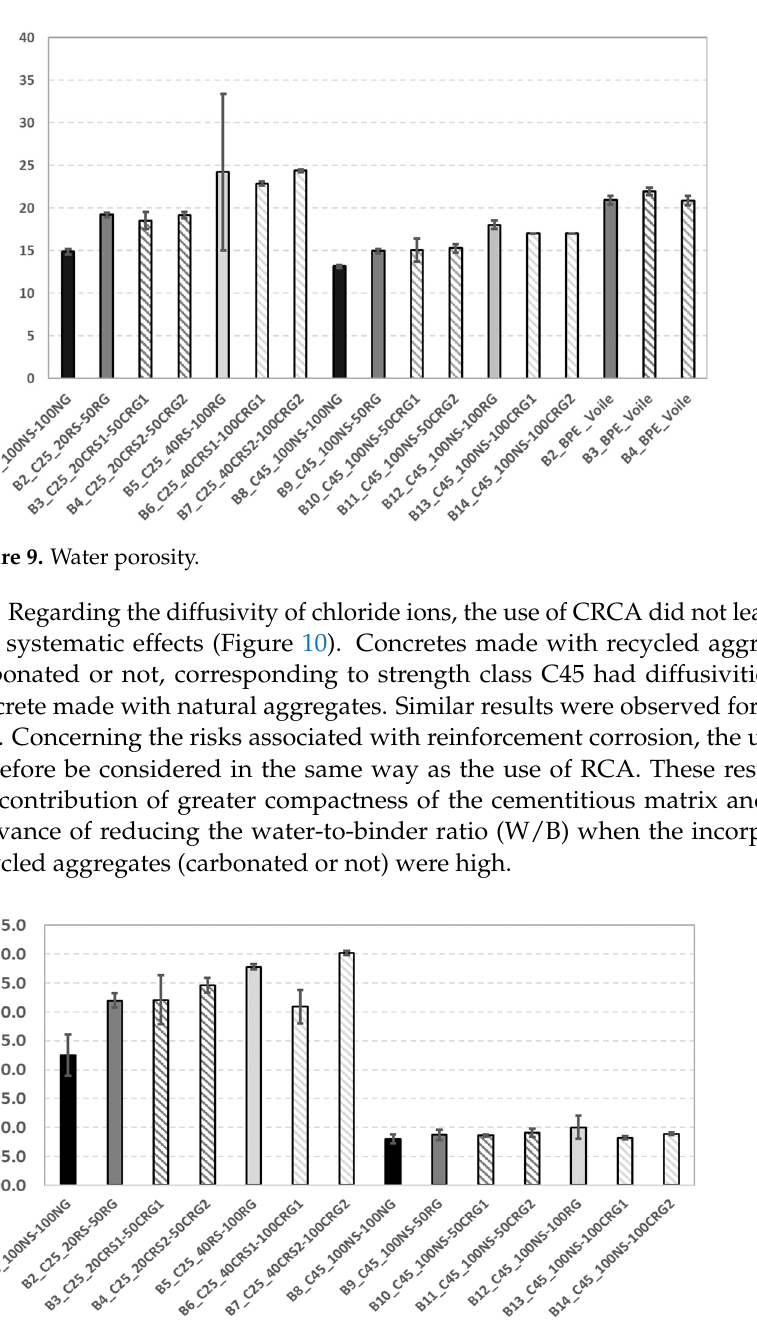
Figure 10. Non-steady-state chloride diffusion coefficients obtained from migration tests (French norm XP P18-462 [16]).